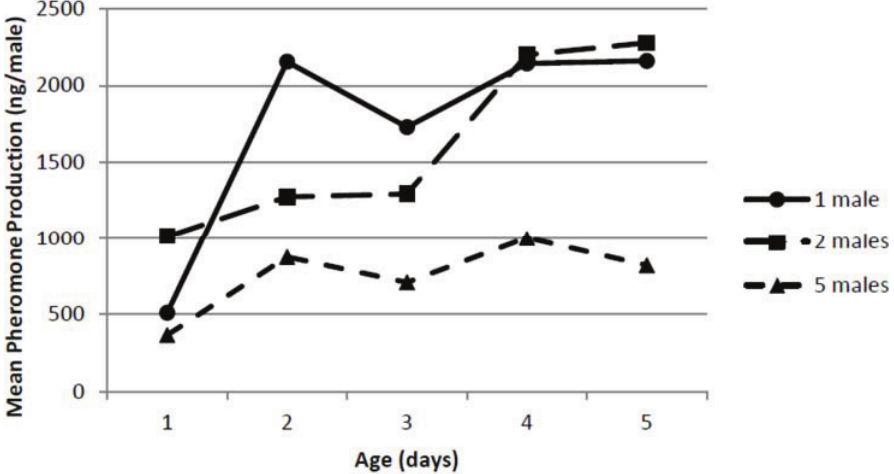
Figure 3. Effect of male density and age on pheromone production.